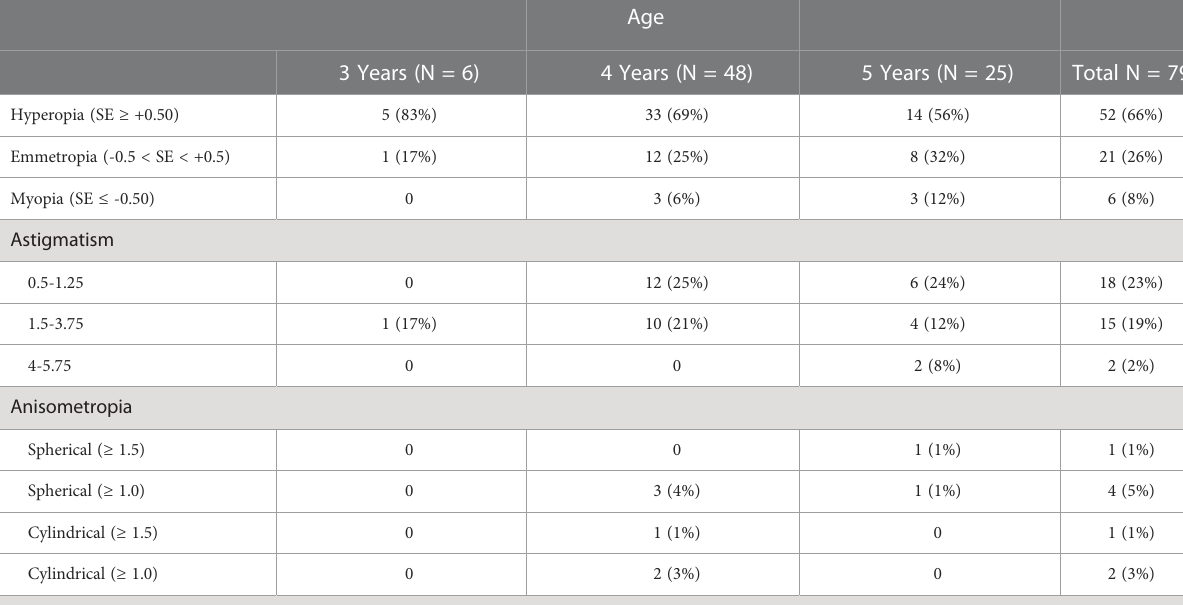
TABLE 1 Refractive Error in the Right Eyes of Examined Children